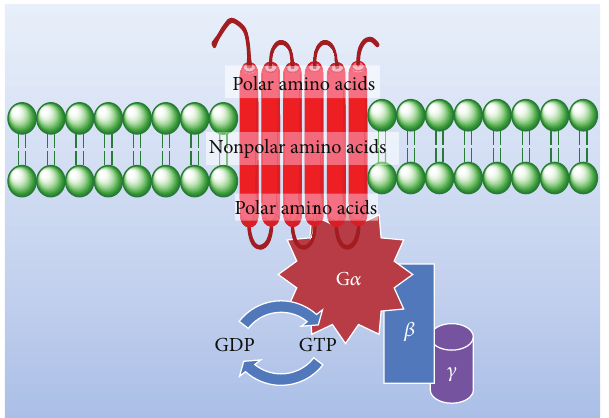
Figure 3: General structure and organization of GPCRs with distri- bution of amino acids within the structure.